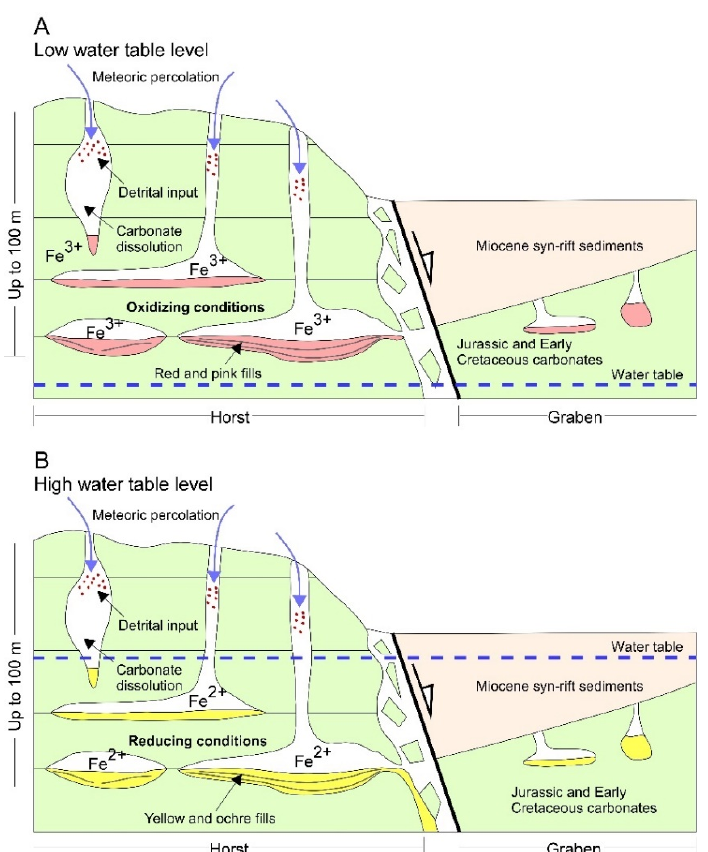
Figure 14. Sketch showing the two scenarios of karst fill accumulation in carbonates in the Pened è s Basin and Amposta Marino C2 and Casablanca-1A oil wells. ( A ) Low water table level characterised by oxidising conditions and accumulation of red to pink fills. ( B ) High water table level characterised by more reducing conditions and accumulation of yellow to ochre fills. In both scenarios, carbonate dissolution and meteoric and detrital input occur. Later dolomitisation of karst fills of the Casablanca- 1A well is not represented in this figure. The penetration of the karst system at depth is based on the distribution of karst fills from the Casablanca-1A and Amposta Marino C2 wells